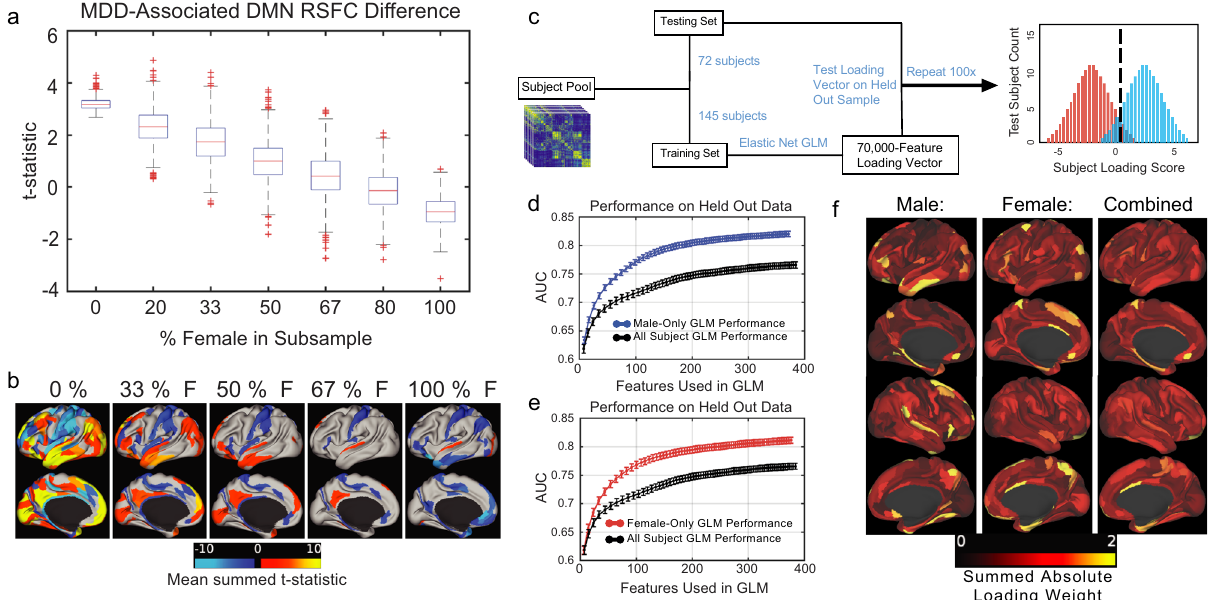
Fig. 6 | Simulating implications of sex differences for rsfMRI analyses and diagnosticclassi fi er performance.a rsFCabnormalities in the DMNvarywith the sex composition of the sample. rsFCabnormalitiesaresummarizedinterms of the mean t-statistic in mass univariate contrasts of each rsFC within the 77-nodeDMN, with boxplots depicting the distribution of the mean t-statistic over 1000 boot- strappedsubsamplesof n =140MDDsubjectsand n =70healthycontrols,selected at random without replacement from the full study sample, across seven different sex compositions (x-axis). b Color map showing the neuroanatomical distribution of the connectivity abnormalities summarized in ( a ). For each functional parcel, signi fi cant t-statistics ( P <0.05, FDR q <0.1) were summed across the 77 DMN